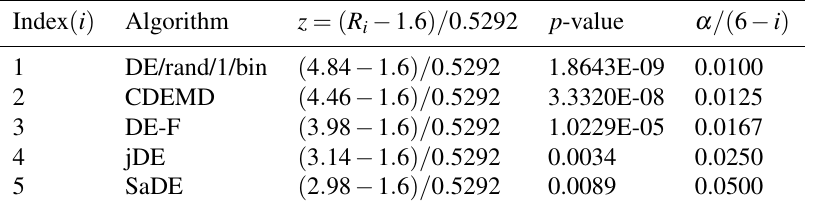
Table 6. Results of the Holm procedure( D =10, α =0.05)